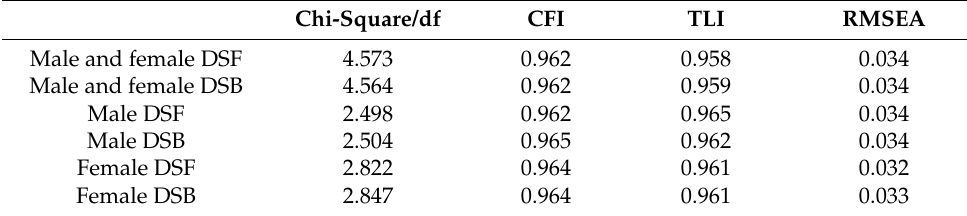
Table 4. Model fit Table 4. Model fit information.